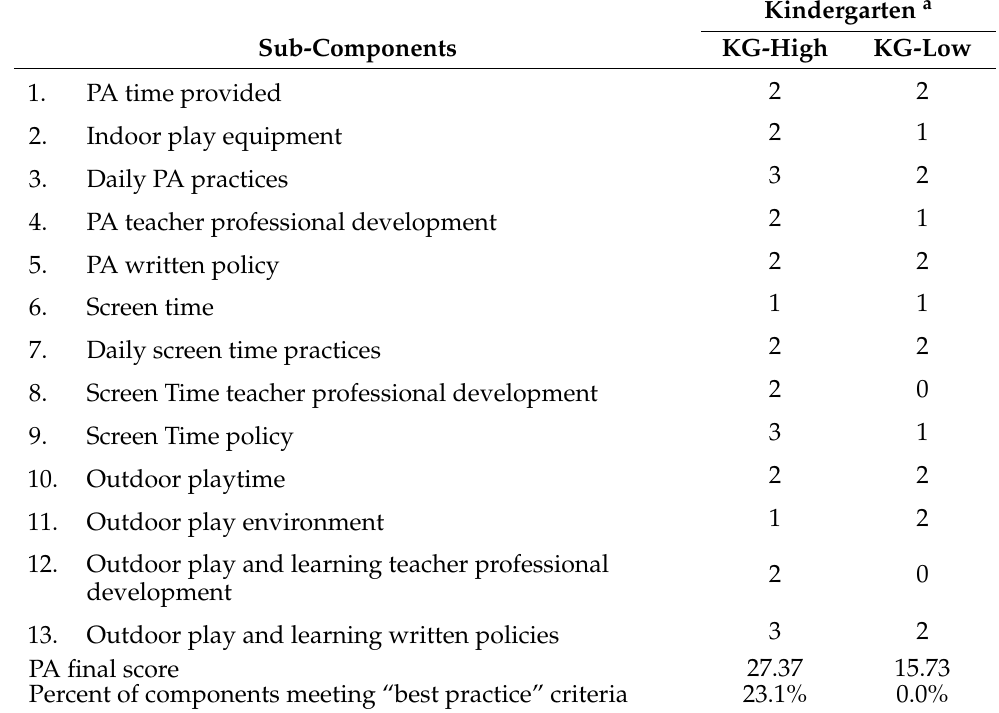
Table 1. Compliance with EPAO-sr best practices to promote PA in each